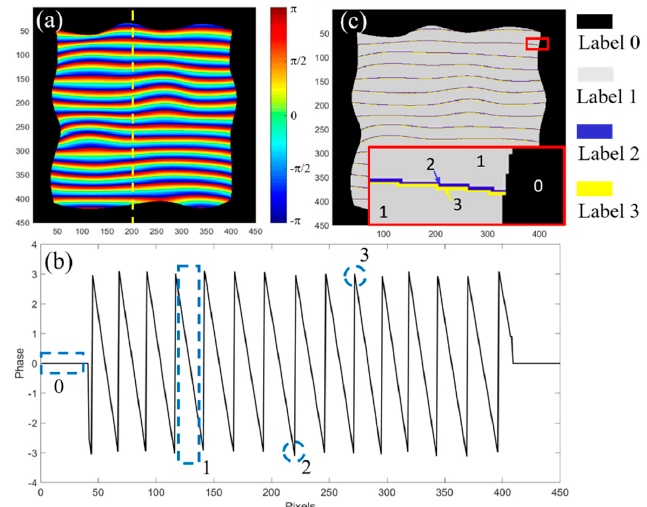
Figure 2. Four features of the wrapped phase for unwrapping phase. ( a ) wrapped phase, ( b ) phase distribution of one column indicated by the yellow dashed line in ( a ), and ( c ) segmented wrapped phase with labels.